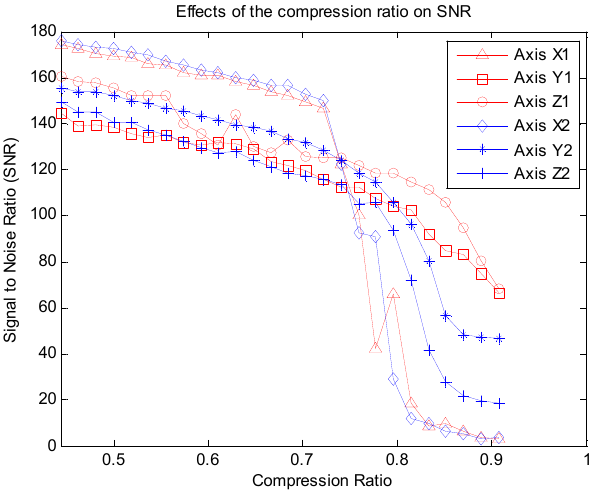
Figure 8. Effects of the compression ratio on SNR.